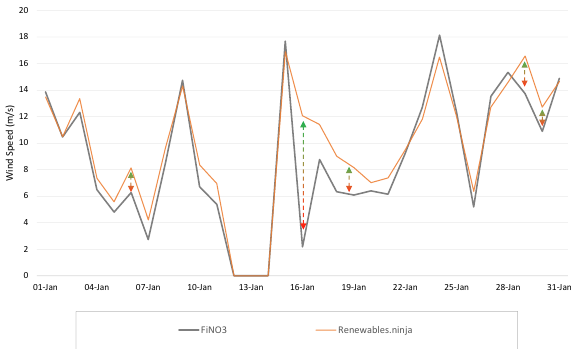
Figure 22. Monthly comparison (January 2018). Own elaboration.